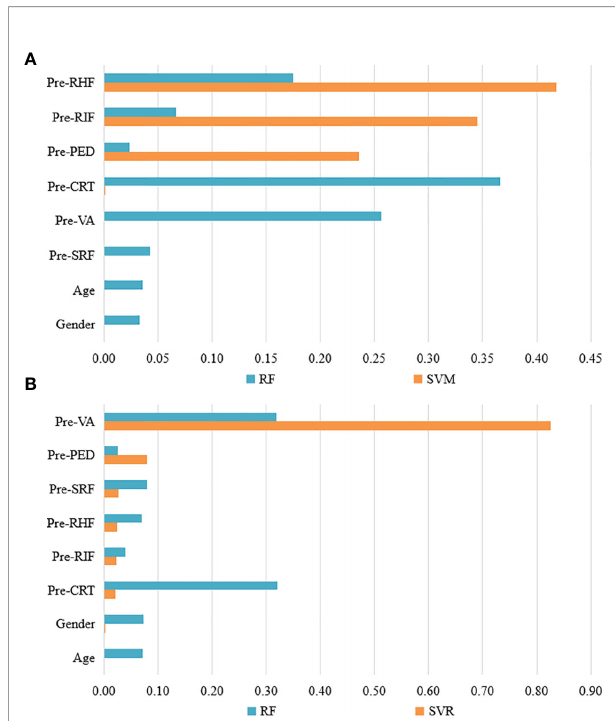
FIGURE 2 | The feature weights of CI and VA predictions of the best two models. (A) The feature weights of CI predictions with RF and SVW models. (B) The feature weights of VA predictions with RF and SVR models. VA, visual acuity; CI, continuous injection; CRT, central retinal thickness; RIF, retinal interlayer fl uid; SRF, sub retinal pigment epithelium fl uid; PED, retinal pigment epithelial detachment; RHF, retinal hyperre fl exia; RF, random forest; SVM, support vector machines; SVR, support vector